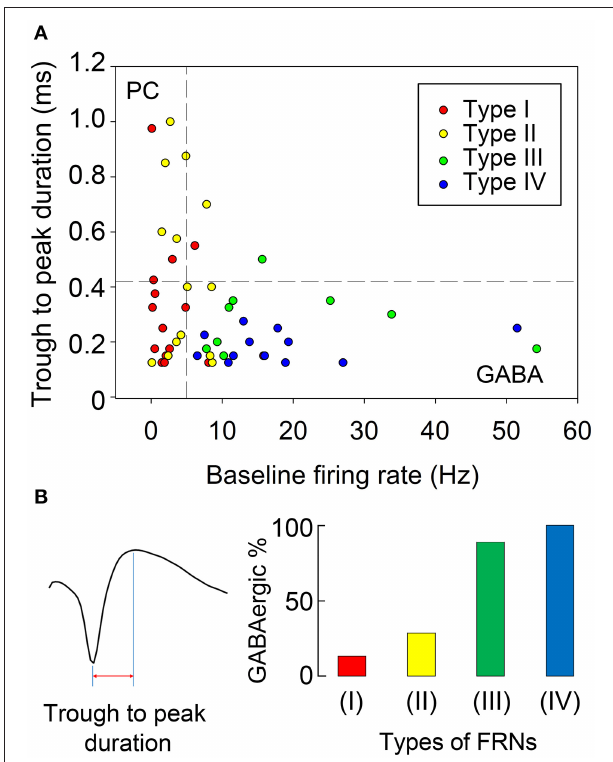
FIGURE 6 | Discrimination of putative GABAergic and glutamatergic FRNs. (A) We set the trough to peak threshold of 0.42 ms and baseline firing rate threshold 5 Hz to separate scatters into four quadrants. Putative glutamatergic neurons were in quadrant II (TPD > 0.42 ms, BFR < 5 Hz), putative GABAergic neurons were in quadrant IV (TPD < 0.42 ms, BF R > 5 Hz) and undetermined cells are in quadrant I and III. 26 FRN were set as putative GABAergic neurons and 8 FRNs were set as putative glutamatergic neurons, remaining 16 FRNs were set as undetermined cells. (B) Trough to peak duration of FRNs’ extracellular spike waveform was showed as example in the left. Composite of each type of FRNs were showed in the right, each color represented GABAnergic neuron in each type FRNs. Type I & II FRNs had a mixed composition of putative glutamatergic and GABAergic neurons, although 66% type I and 36% type II remain undetermined. 89% type III and 100% type IV FRNs belonged to putative GABAergic